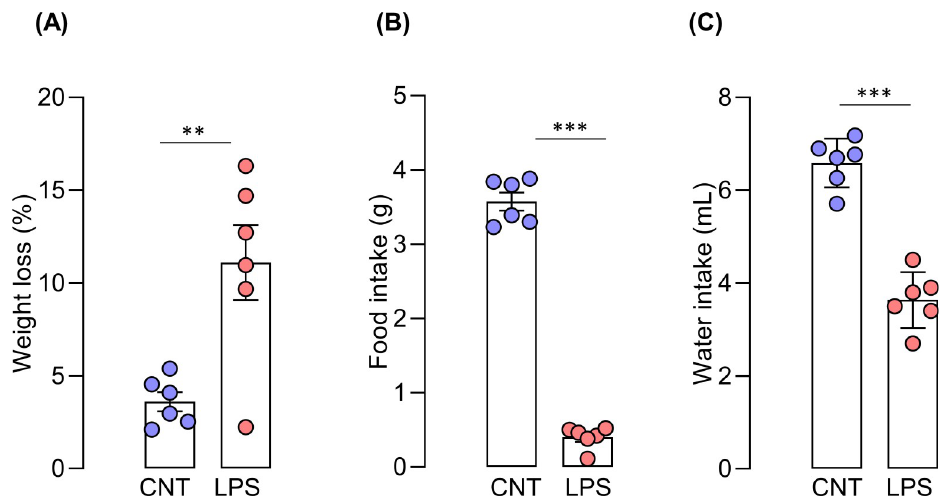
Fig 9. Bodyweight changes, food, and water intake. (A) Percentage of body weight changes, (B) Food and (C) water intake of mice after LPS exposure. Unpaired t-test, N = 6 mice per group; �� p < 0.01, ��� p < 0.001 compared with the control